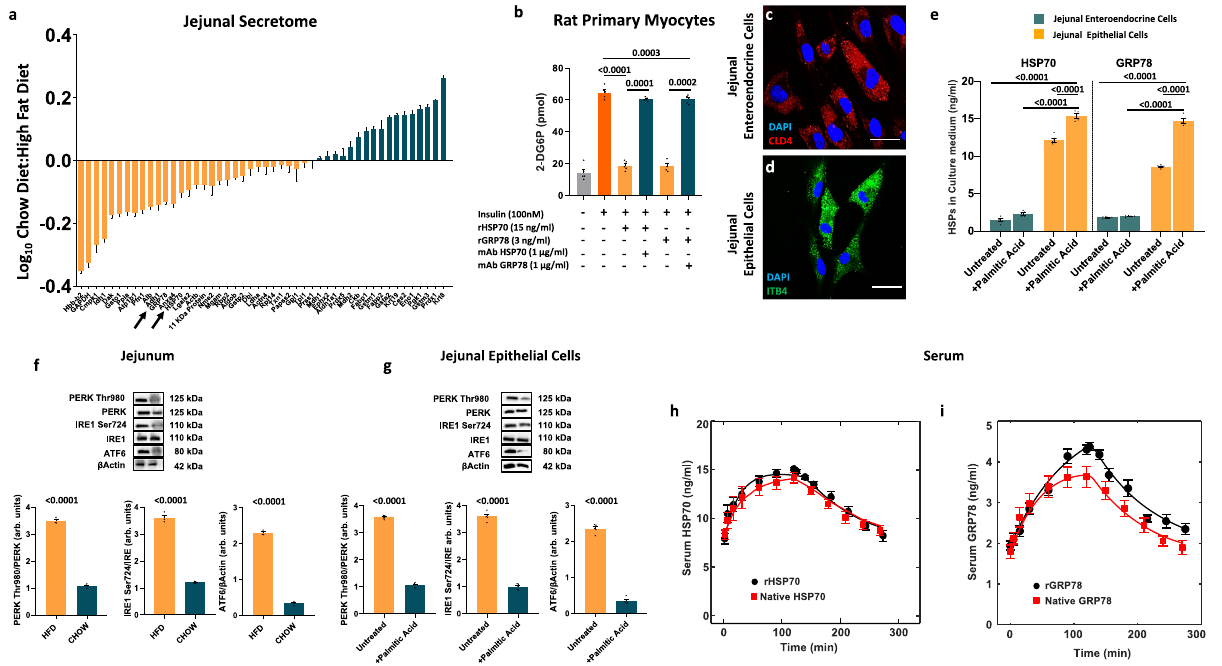
Fig. 1 | Sites of intestinal heat shock proteins release and their kinetics and action. a iTraQ-based analysis of proteins ( n =48) differentially expressed in the jejunal secretome in chow diet versus high-fat diet ( n =4 biologically independent animals). Downregulated proteins ( n =17) are colored in green while upregulated proteins ( n =31) are colored in orange. b Insulin-mediated glucose uptake of rat primary myocytes treated with HSP70 (15ng/ml), GRP78 (3ng/ml) alone or in combination with their respective mAbs (1 μ g/ml). Rat myocytes were stimulated with 100nM insulin for 10min ( n =5 independent experiments). c , d Representative confocal microscopy images of FACS isolated rat enter- oendocrine cells ( c ) stained for Claudin-4 (CLD4,red) and rat intestinal epithelial cells ( d ) stained for Integrin- β 4 (ITB4,green) ( n =5 independent experiments). e HSP70andGRP78concentrationintheculturemediumofratintestinalepithelial andenteroendocrinecellsuntreated orstimulatedwith0.5mMpalmiticacid( n =5